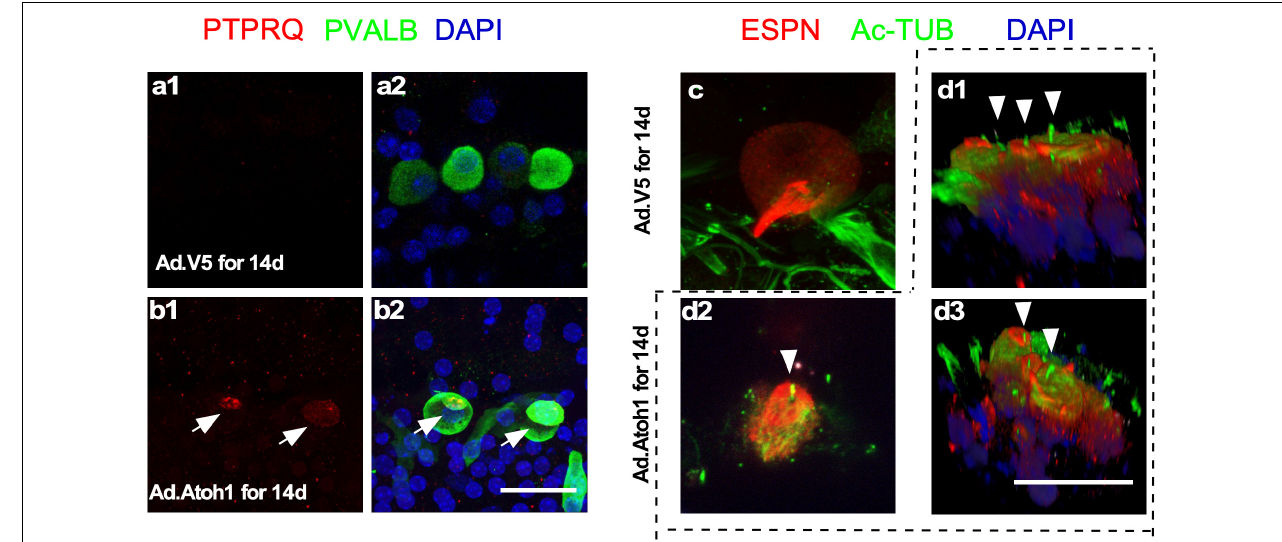
FIGURE 6 | Regenerated HCLCs resemble developmentally young, immature HCs. (a1,a2) In control cultured adult cochleae infected with Ad-V5, an early HC marker PTPRQ was not detected in the existing surviving IHCs. (b1,b2) In Ad-Atoh1-infected adult cochleae in culture, PTPRQ was seen in the stereocilia structures in the regenerated HCLCs (arrows). (c) Kinocilia were not detected in control cochlear IHCs by acetylated tubulin (Ac-TUB) labeling after Ad-V5 infection in cultured adult cochleae. (d1–d3) Ac-TUB labeled kinocilia were observed in regenerated ESPN + HCLCs after Ad-Atoh1 infection in cultured adult cochleae (arrowheads). Scale bars: 25 µ